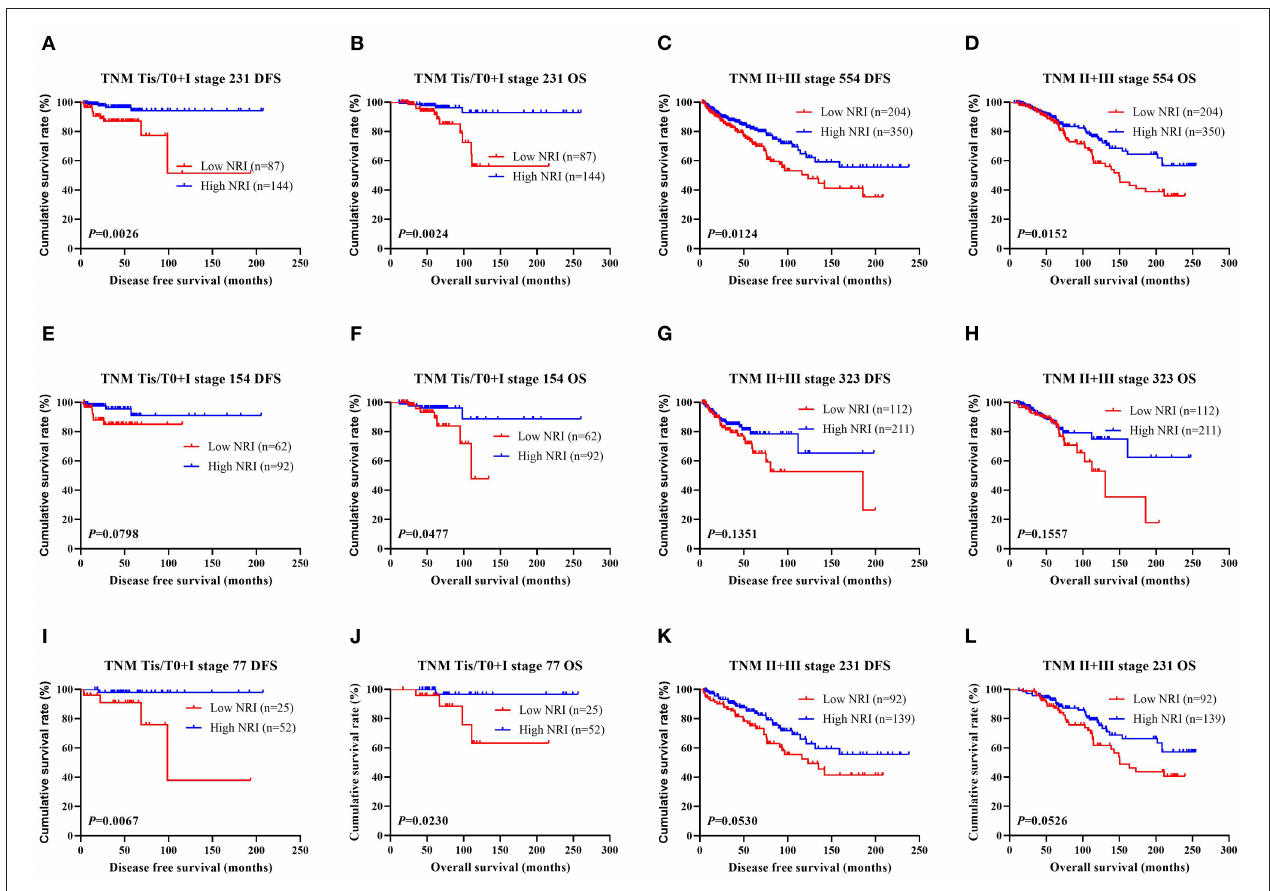
FIGURE 2 | DFS and OS for the NRI of breast cancer patients in different pathologic stages. (A) Kaplan-Meier analysis of DFS for the NRI scores of early-stage breast cancer (Tis/T0 + I stage) patients in all enrolled breast cancer patients. (B) Kaplan-Meier analysis of OS for the NRI values of early-stage breast cancer (Tis/T0 + I stage) patients in all enrolled breast cancer patients. (C) Kaplan-Meier analysis of DFS for the NRI values of advanced stage breast cancer (II + III stage) patients in all enrolled breast cancer patients. (D) Kaplan-Meier analysis of OS for the NRI levels of advanced stage breast cancer (II + III stage) patients in all enrolled breast cancer patients. (E) Kaplan-Meier analysis of DFS for the NRI values of early-stage breast cancer (Tis/T0 + I stage) patients in NACT group. (F) Kaplan-Meier analysis of OS for the NRI scores of early-stage breast cancer (Tis/T0 + I stage) patients in NACT group. (G) Kaplan-Meier analysis of DFS for the NRI values of advanced stage breast cancer (II + III stage) patients in NACT group. (H) Kaplan-Meier analysis of OS for the NRI values of advanced stage breast cancer (II + III stage) patients in NACT group. (I) Kaplan-Meier analysis of DFS for the NRI scores of early-stage breast cancer (Tis/T0 + I stage) patients in non-NACT group. (J) Kaplan-Meier analysis of OS for the NRI scores of early-stage breast cancer (Tis/T0 + I stage) patients in non-NACT group. (K) Kaplan-Meier analysis of DFS for the NRI values of advanced stage breast cancer (II + III stage) patients in non-NACT group. (L) Kaplan-Meier analysis of OS for the NRI of advanced stage breast cancer (II + III stage) patients in non-NACT